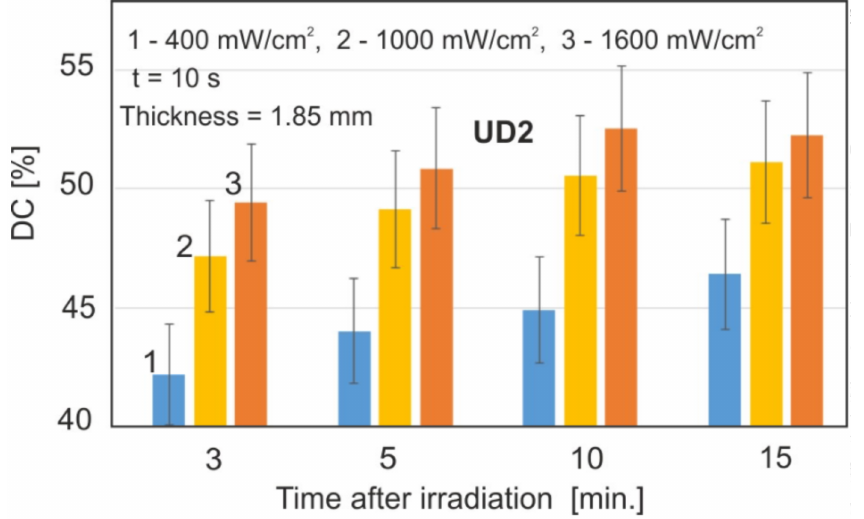
Figure 4. Effect of power density on DC values.